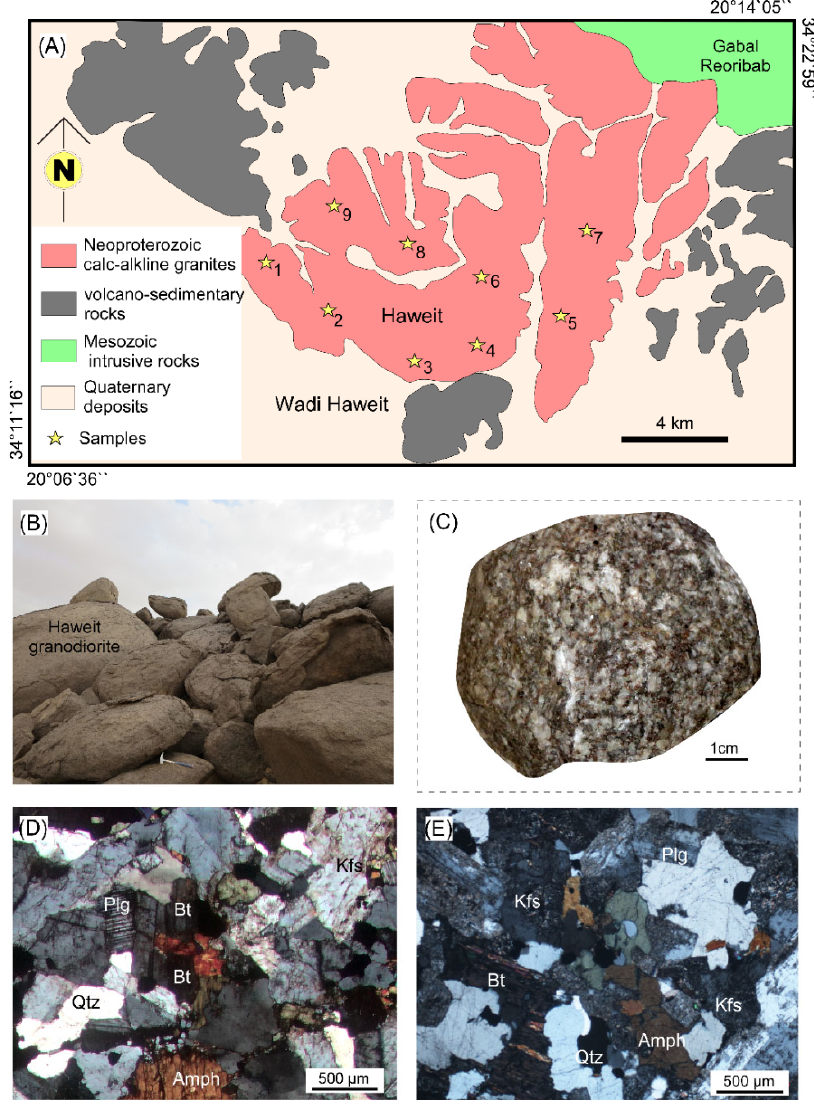
Figure 2. ( A ) Geological map of the Haweit area showing lithological units and samples location. Dated zircon crystals were separated from the fresh granitic sample (HG6); ( B ) field photograph showing the boulder appearance of the Haweit low hills granodiorites; ( C ) macroscopic image of granodiorite hand specimen; ( D,E ) photomicrograph (XPL) showing the main minerals components and the hypidiomorphic texture of the granodiorite, Pl—plagioclase, Qtz—quartz, Kfs—k ‐ feldspar,